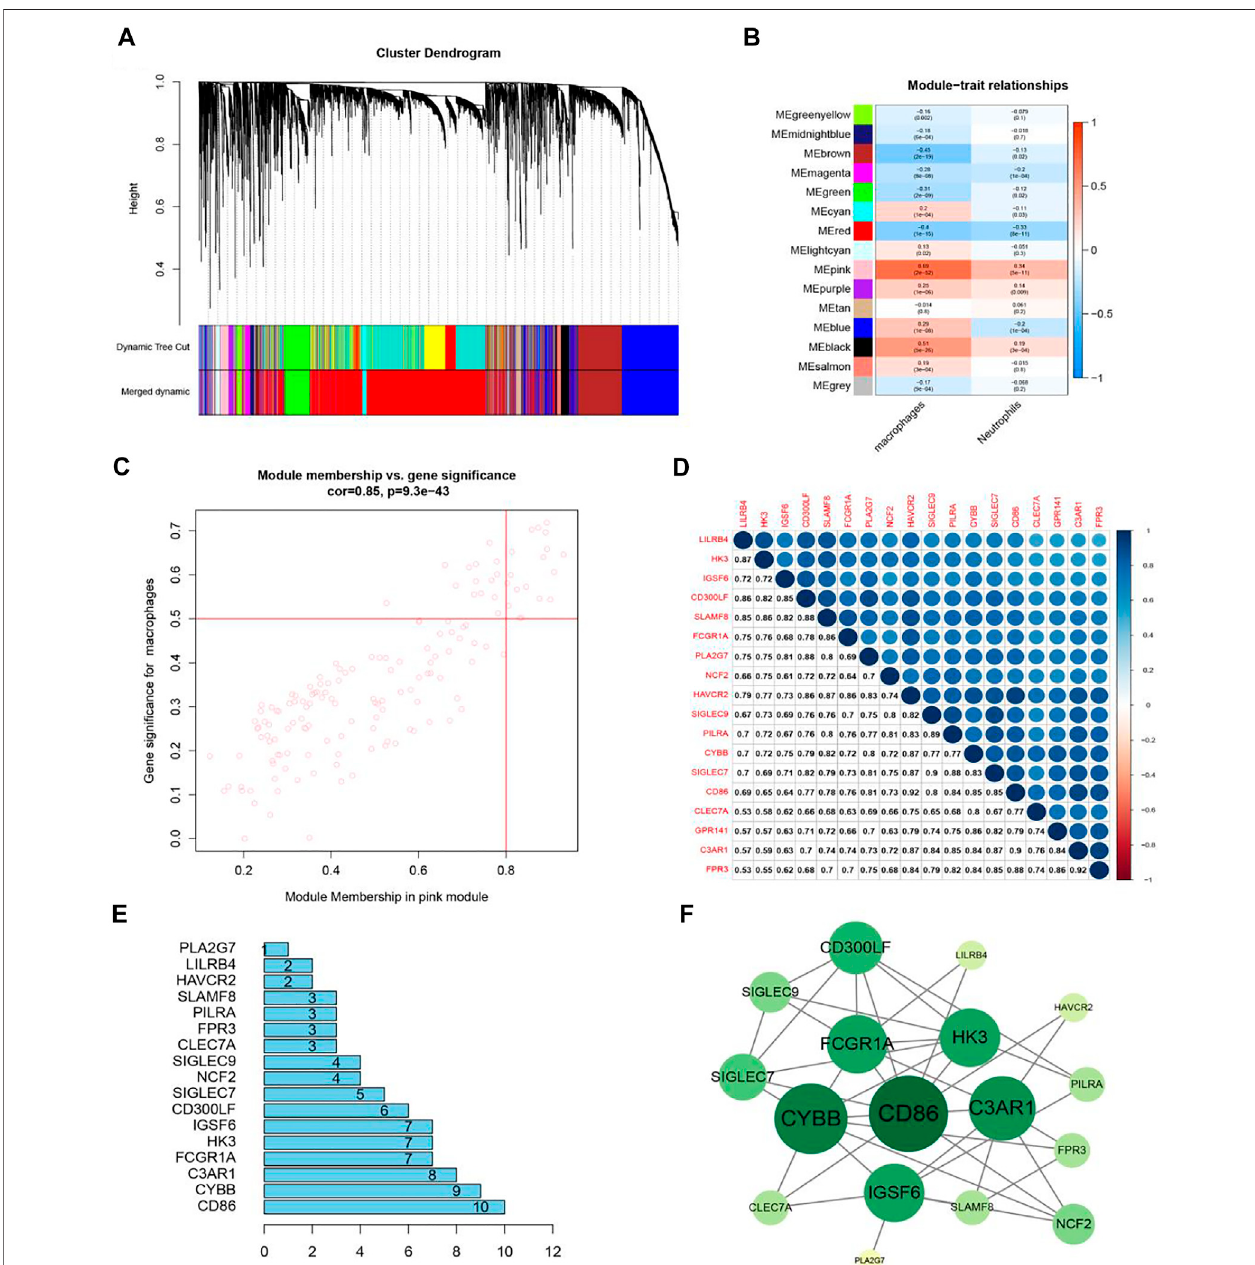
FIGURE 5 | The identi fi cation of key modules and genes. (A) Co-expression gene modules were acquired from a hierarchical cluster dendrogram. (B) Heatmap displays correlations of module eigengenes with macrophages. (C) In the MEpink module, each dot represented a gene. The upper right corner of the scatter plot showed genes under the condition of MM > 0.8 and GS > 0.5. (D) The correlation heat map of 18 genes. (E) Core genes in PPI. (F) Co-expression of key genes and upstream genes.